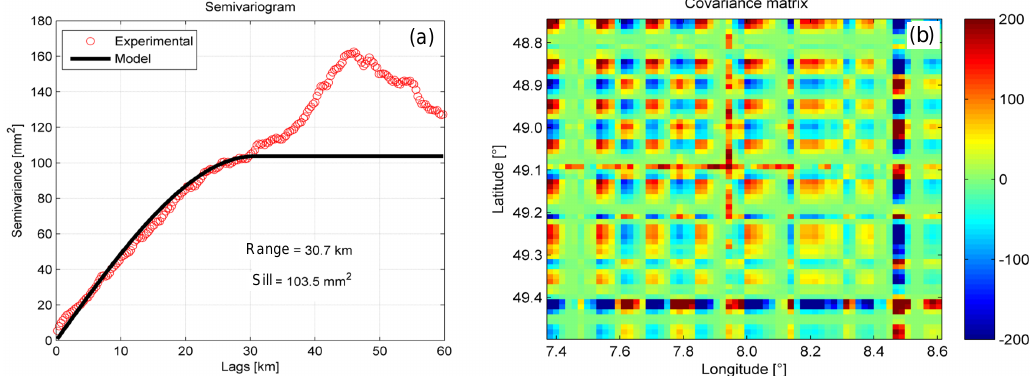
Figure 9. (a) The experimental semivariogram and the fitted spherical variogram model. (b) Covariance matrix used to predict the wet delay maps in Fig. 10.